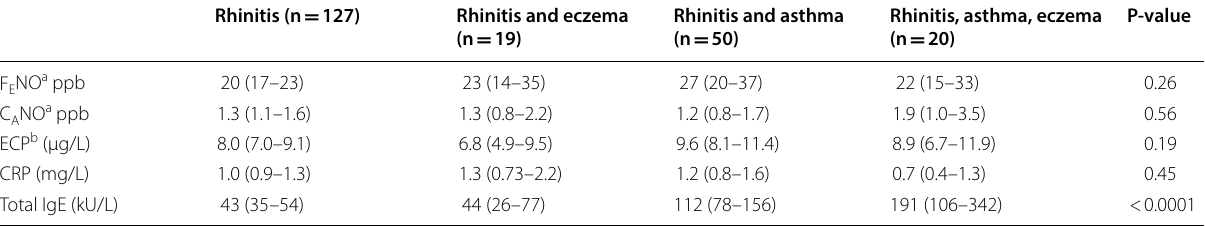
F E NO exhaled nitric oxide, C A NO the estimated alveolar NO concentration, ECP eosinophil cationic protein, CRP C-reactive protein a Available in 128 participants b Available in 178